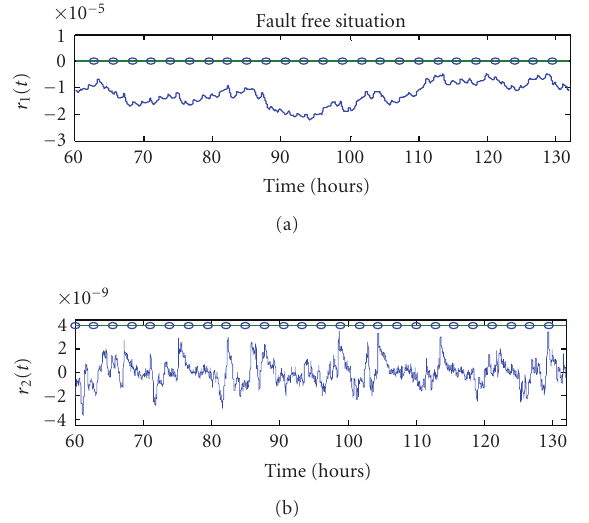
Figure 10: Behavior of r i ( t ), i = 1,2 and the decision test-hydrazine sensor fault (120